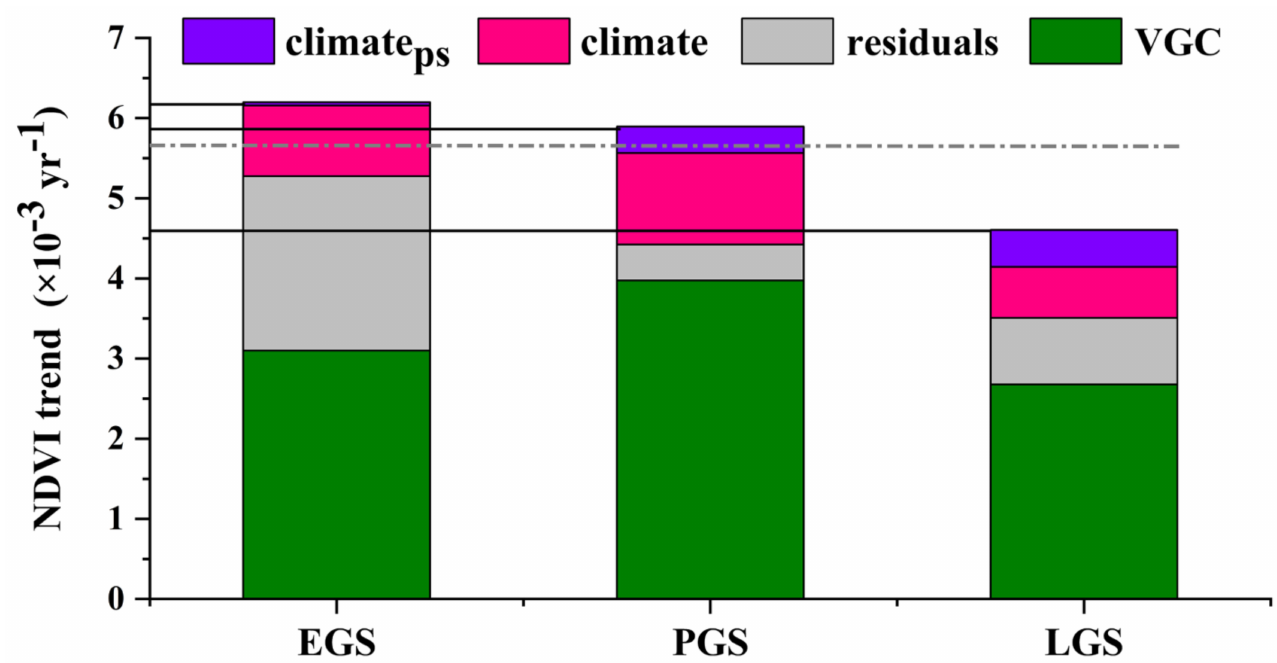
Figure 8. Individual contributions of the vegetation growth carryover (VGC) and the immediate (climate) and lagged (climate ps ) climate effects to seasonal NDVI trends over a 20-year period (2000–2019). The gray dashed line indicates the 20-year growing-season mean NDVI trend. The black solid lines indicate the observed NDVI trends of each